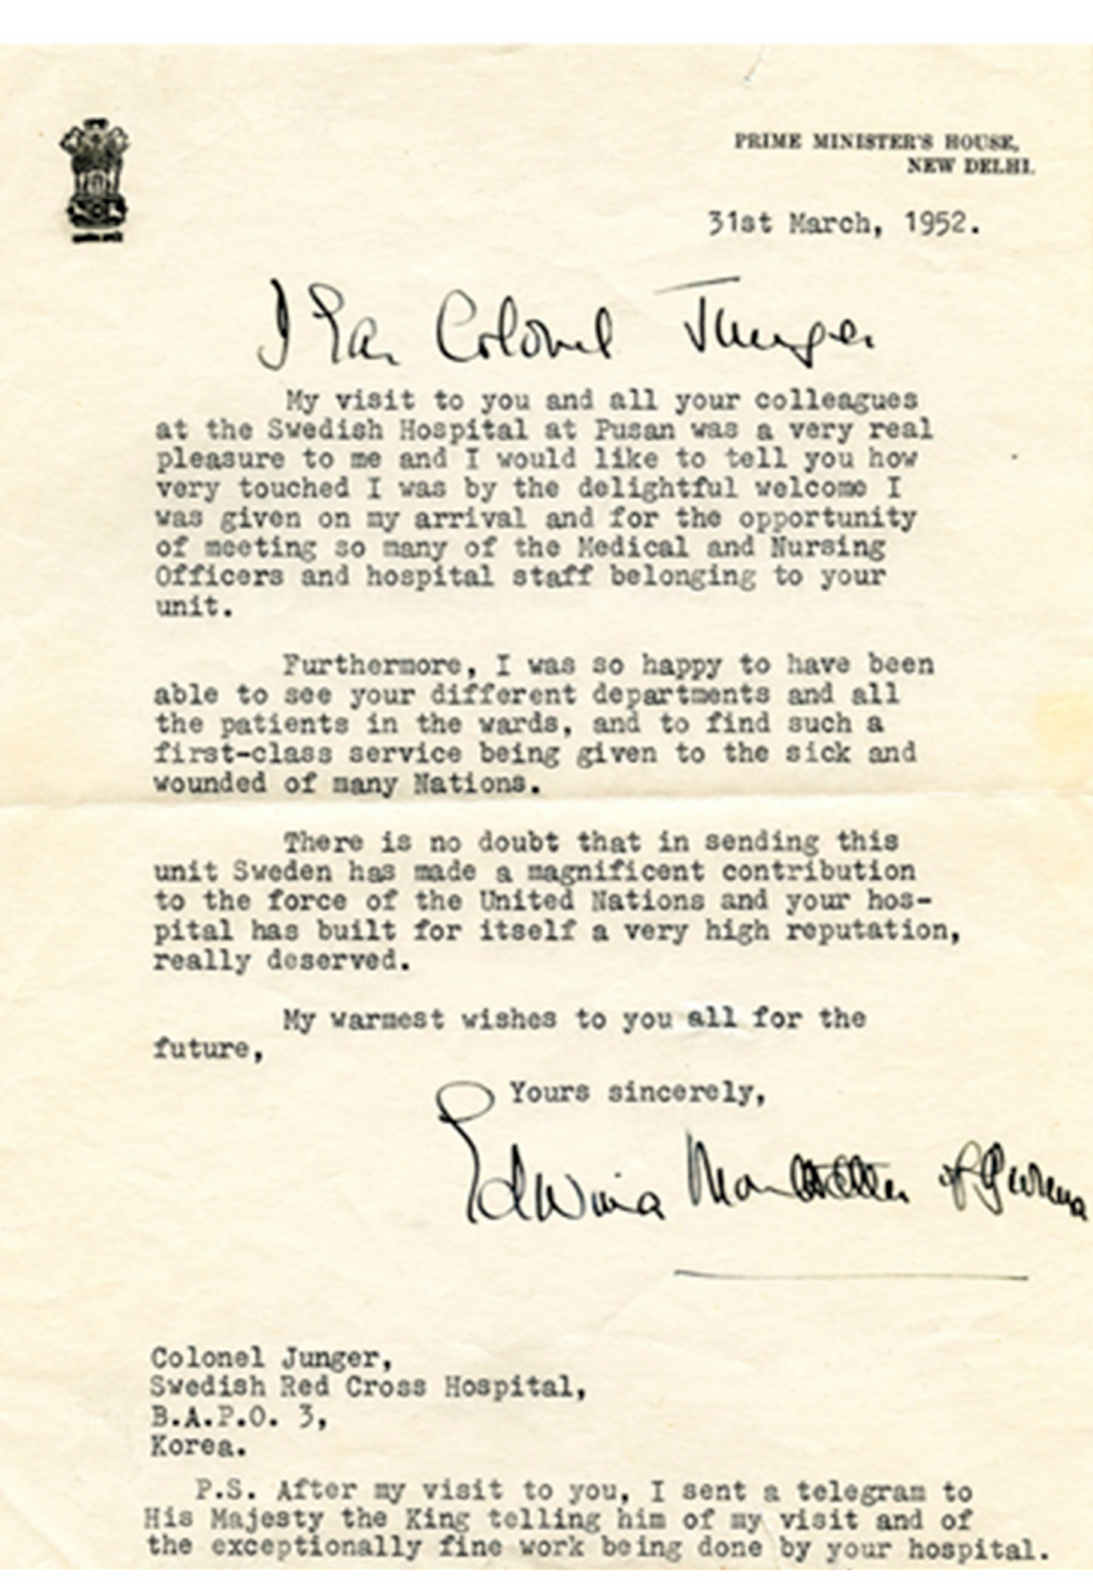
Figure 3. Letter from Edwina Mountbatten, former Vicereine and Governor of India, 31 March